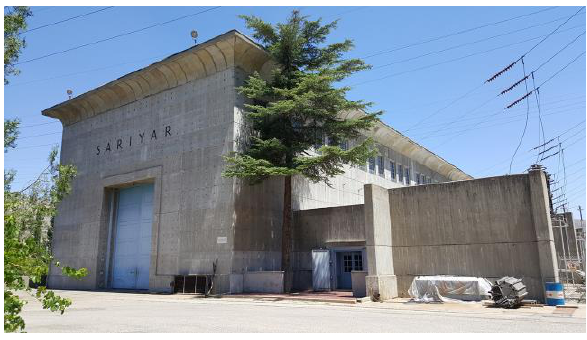
Figure 6. Sarıyar Powerhouse